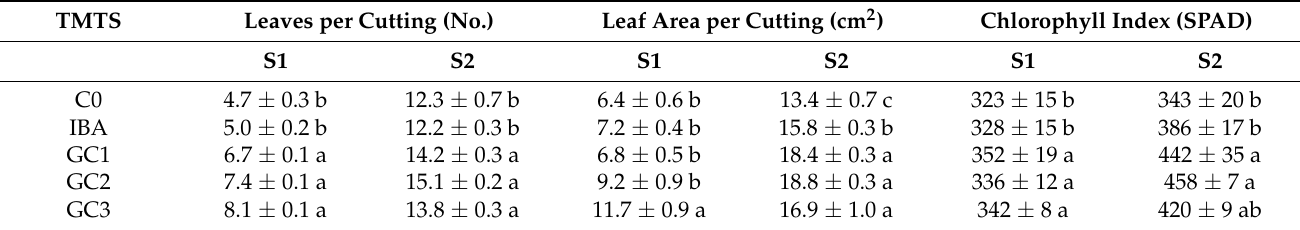
Table 2. Aerial morpho-biometric traits: leaves per cutting (no.), leaf area per cutting (cm 2 ) and chlorophyll index (SPAD) in Lantana camara (S1) and Abelia × grandiflora (S2), influenced by rooting promoters at different concentrations (C). Leaf Area per Cutting (cm 2